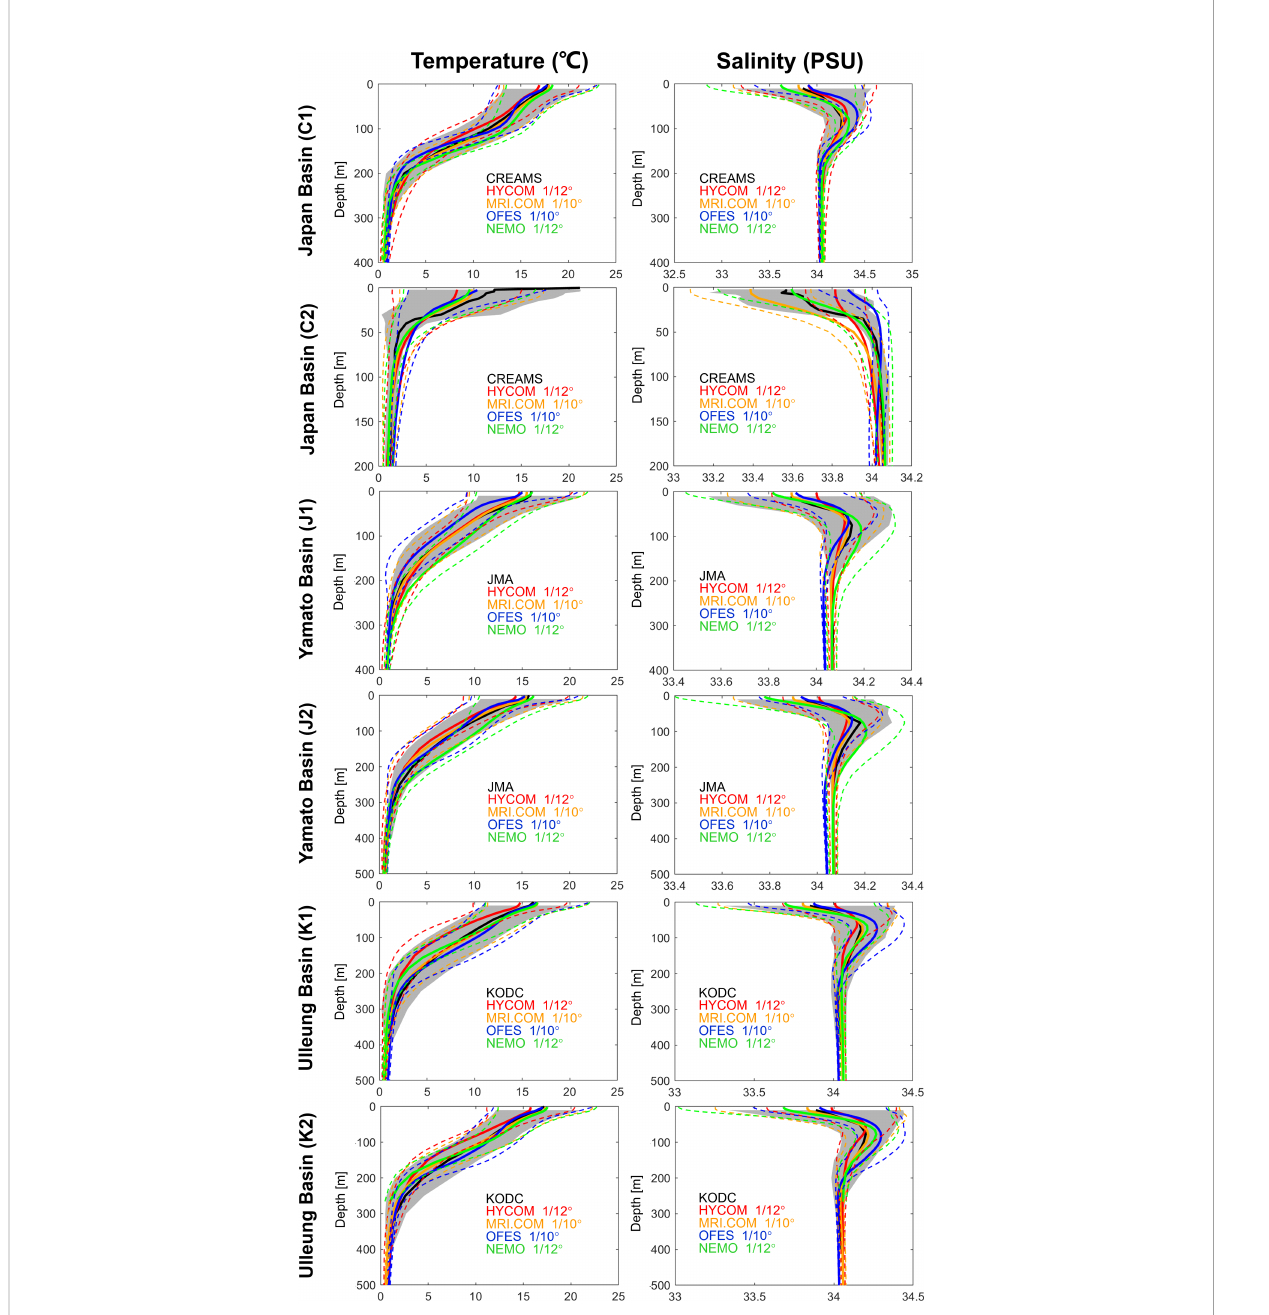
FIGURE 2 Mean vertical pro fi les of temperature (left) and salinity (right) observed by six representative stations (black) and simulated by four eddy-resolving ocean models HYCOM (red) and OFES (blue) with 1/12° resolution, MRI.COM (orange) and NEMO (green) with 1/12° resolution with 1/2° resolution for the time period from 1993 through 2014. Results for the monitoring stations C1 and C2 in the Japan Basin, J1 and J2 in the Yamato Basin, and K1 and K2 in the Ulleung Basin are displayed from bottom to top. Mean values are illustrated by solid lines. Standard deviations are indicated by the gray-shaded area for the observation data and by the colored dashed lines for the